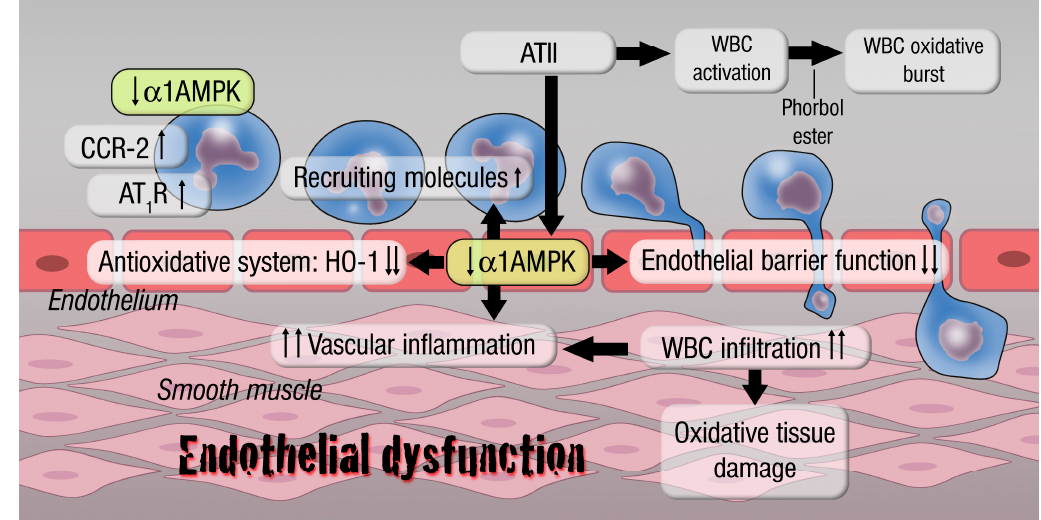
Figure 5. Inflammatory responses on myelomonocytic- and endothelial-specific α 1AMPK knockout cells. Loss of myelomonocytic (LysMCre) ‐ specific α 1AMPK affects vascular and whole blood oxidative stress and endothelial function by regulating the recruitment of inflammatory cells (enhancement of CCR ‐ 2, MCP ‐ 1 and other recruiting molecules) to the vascular wall and higher white blood cell (WBC) activation state (reflected by WBC oxidative burst). This also promotes an increase in angiotensin II receptor type 1, leading to higher responsiveness towards pro ‐ oxidant